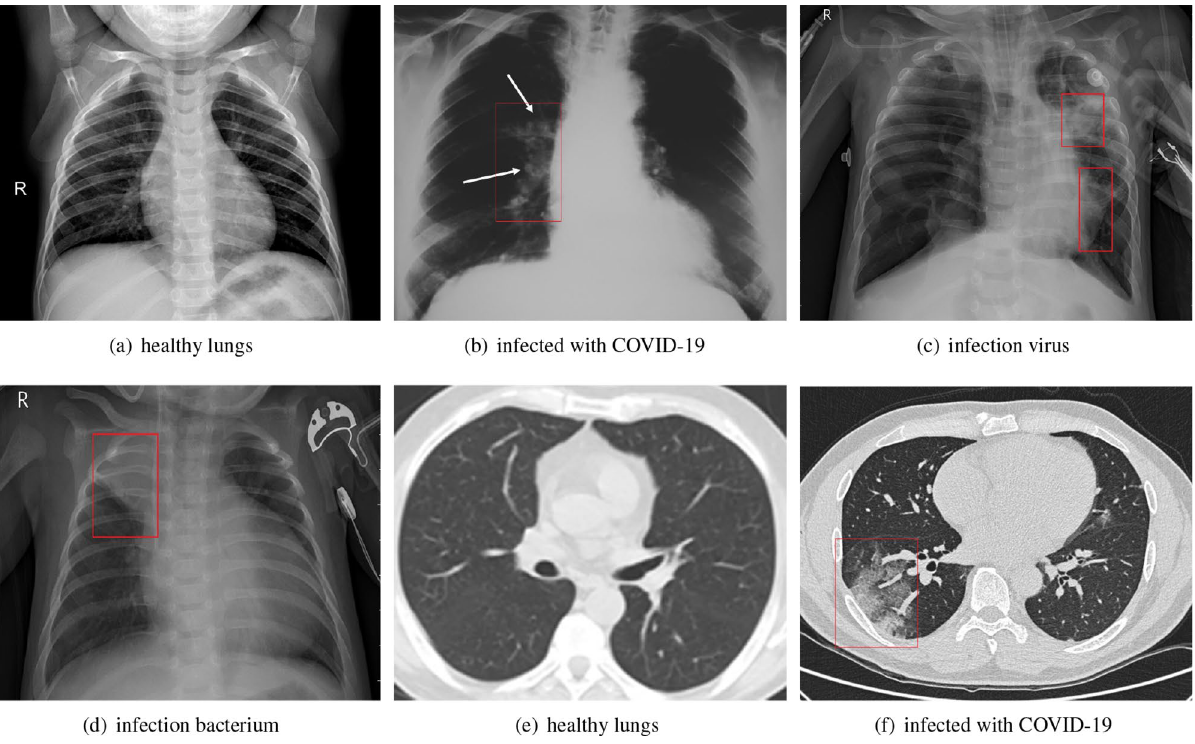
Figure 3. X-ray images ( a – d ) and CT images ( e – f